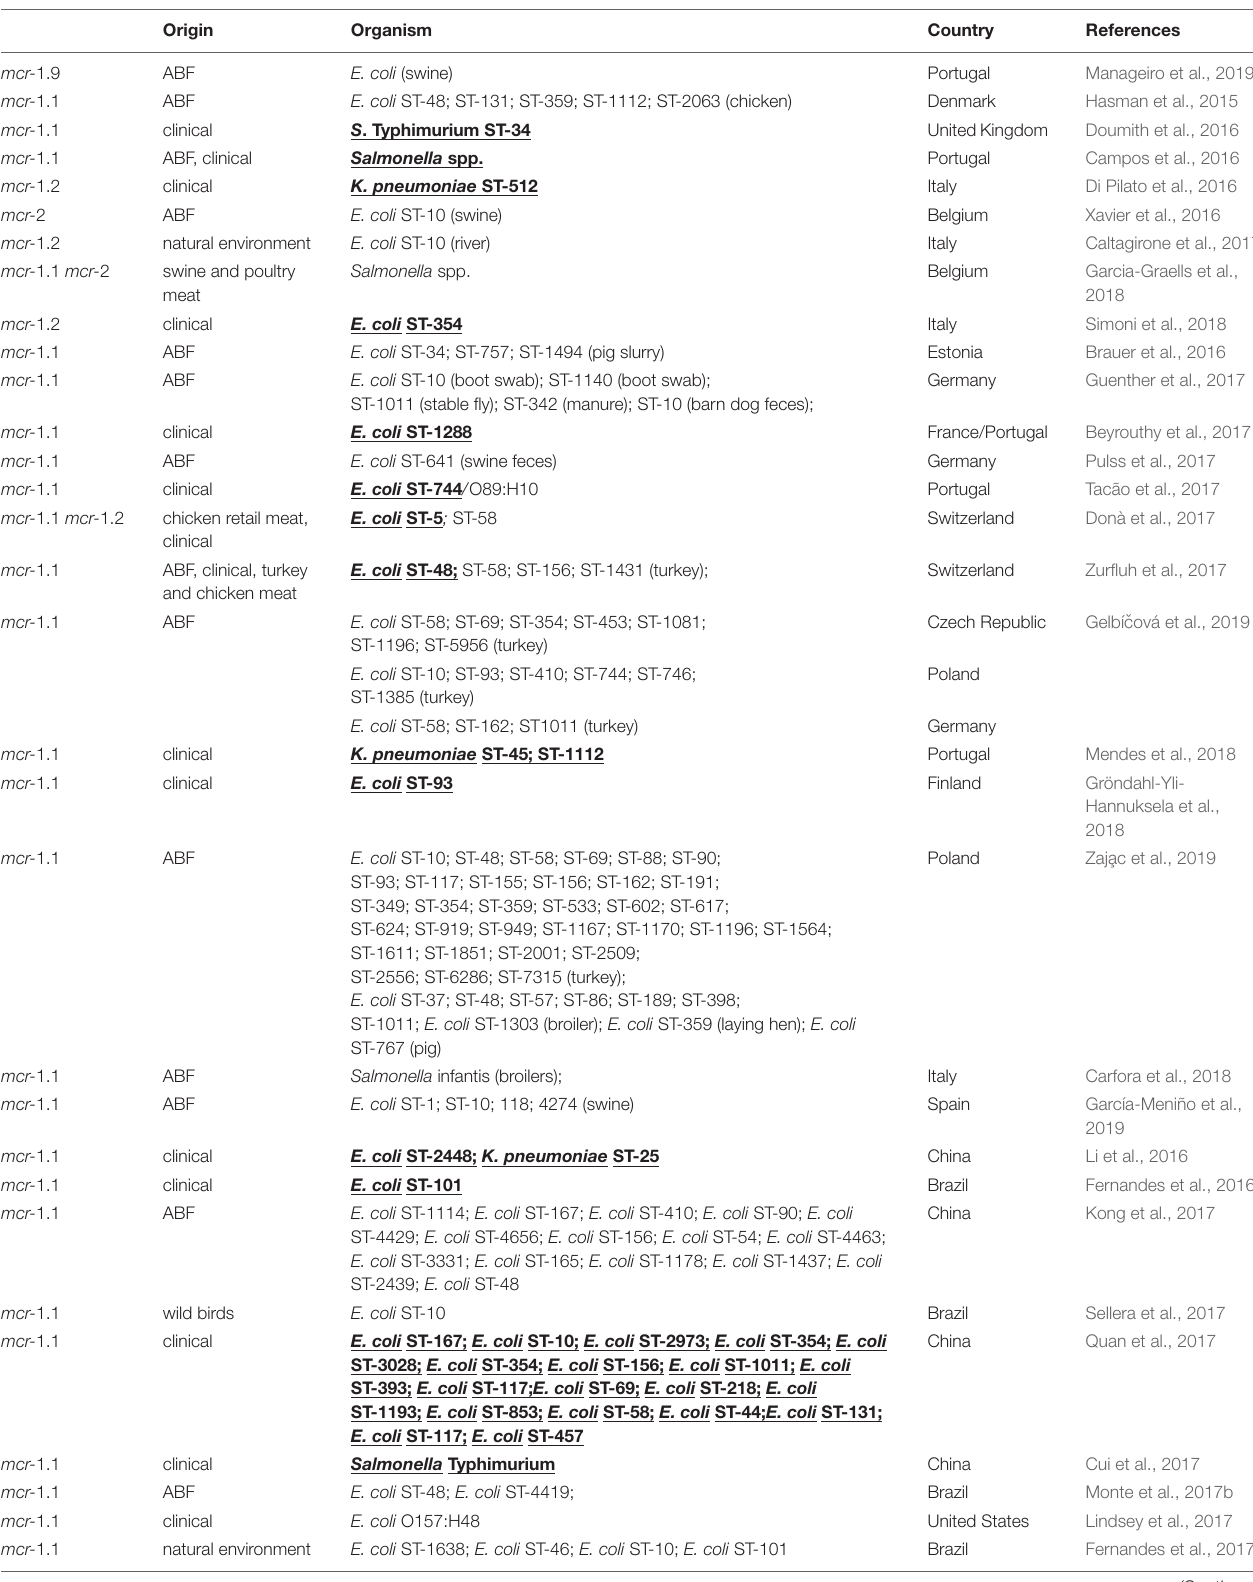
TABLE 6 | Global dissemination of mcr -harboring 33.3 kbp IncX4